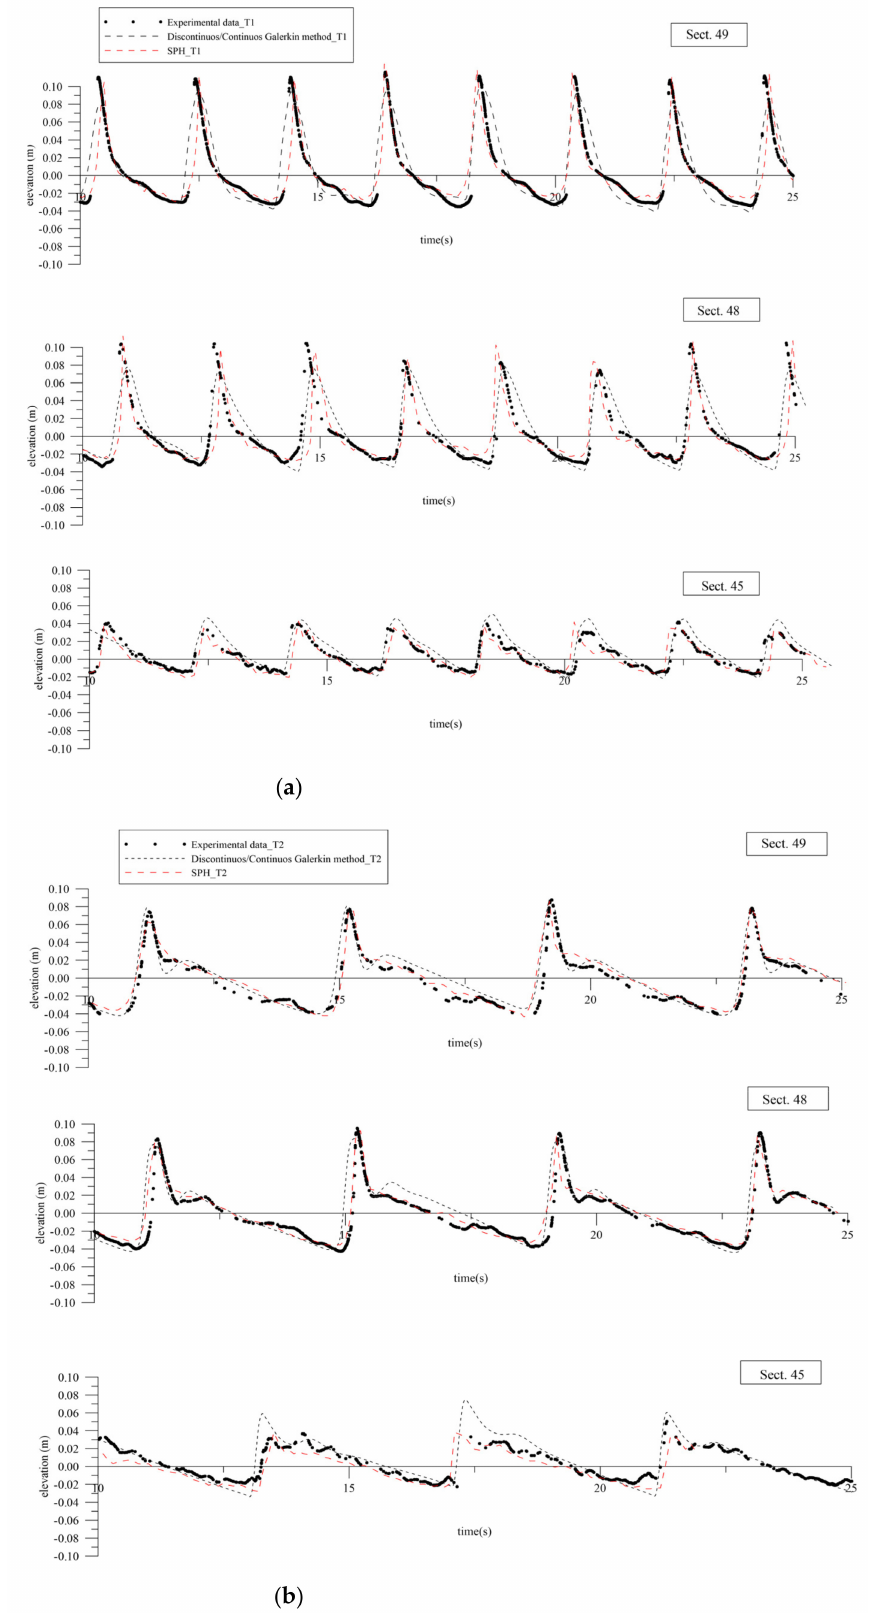
Figure 5. Computed and measured surface elevation for ( a ) spilling/plunging breaking wave (T1) and ( b ) plunging breaking wave